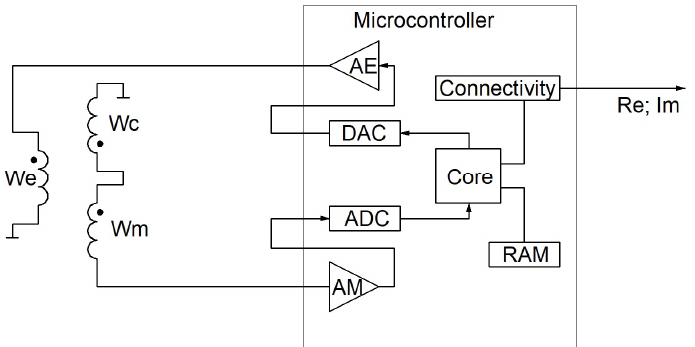
Figure 5. Block diagram of three-coil transformer compensated amplitude-phase eddy-current probe. Here, We—excitation coil, Wc—compensating coil, Wm—measuring coil, AE—excitation signal amplifier, AM—added voltage amplifier.